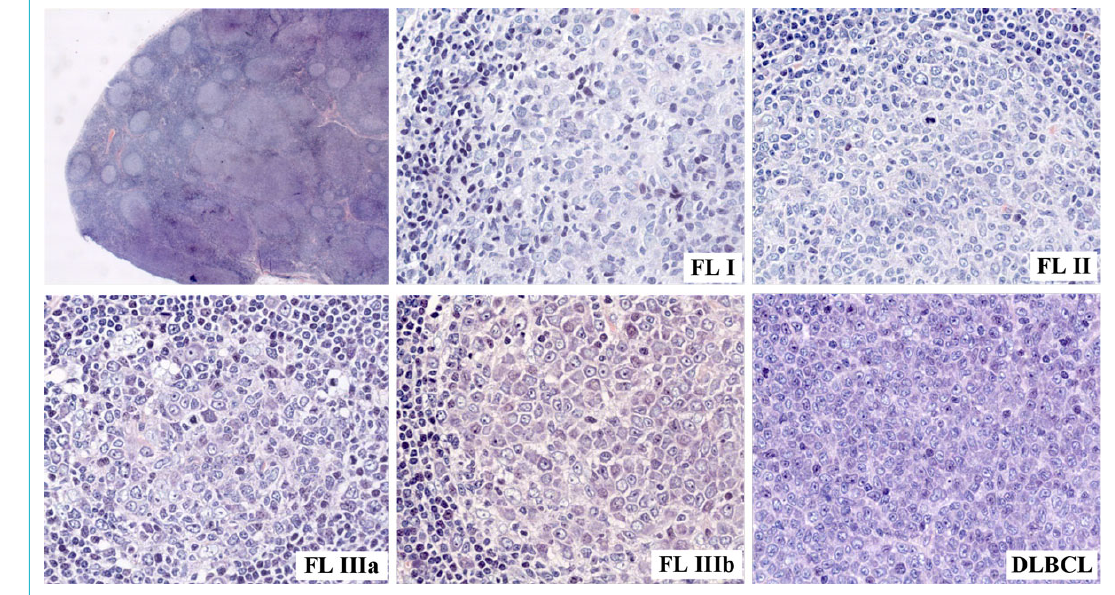
Figure 1: Enlarged cervical lymph node (4 cm in diameter) of a 64-year-old male patient harbouring follicular lymphoma (FL) of varying histo- logical grades, including transformation into a diffuse large B-cell lymphoma